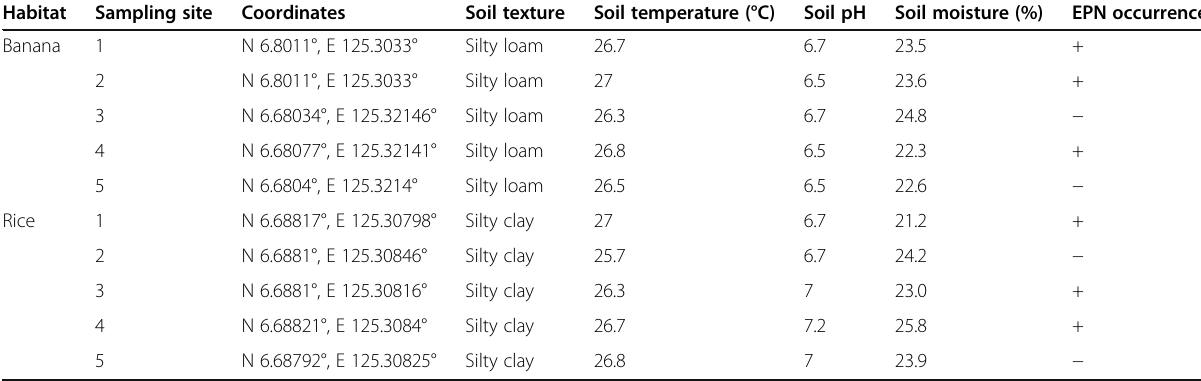
Table 1 Occurrence of entomopathogenic nematodes from banana and rice fields in Hagonoy, Davao del Sur, Philippines, with different soil parameters